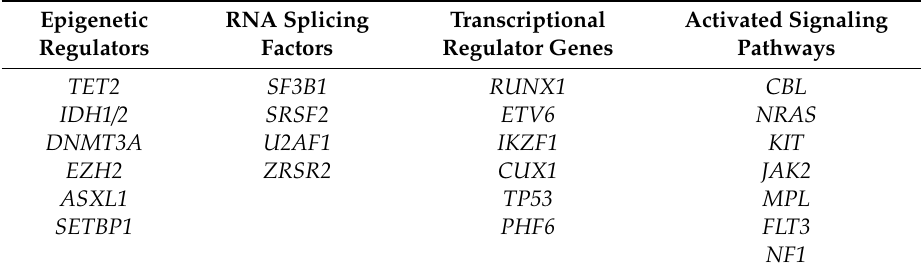
Table 2. Functional classification of the most commonly mutated genes in myeloid